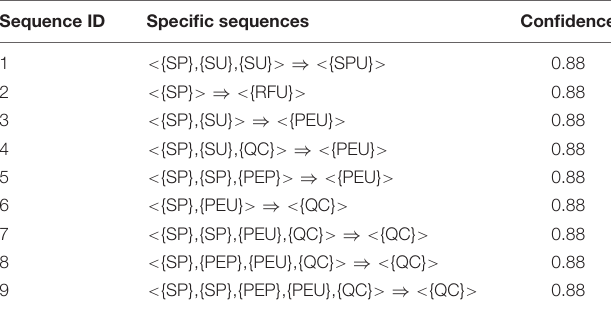
TABLE 8 | Examples of specific discourse move-emotion sequences in metadiscourse